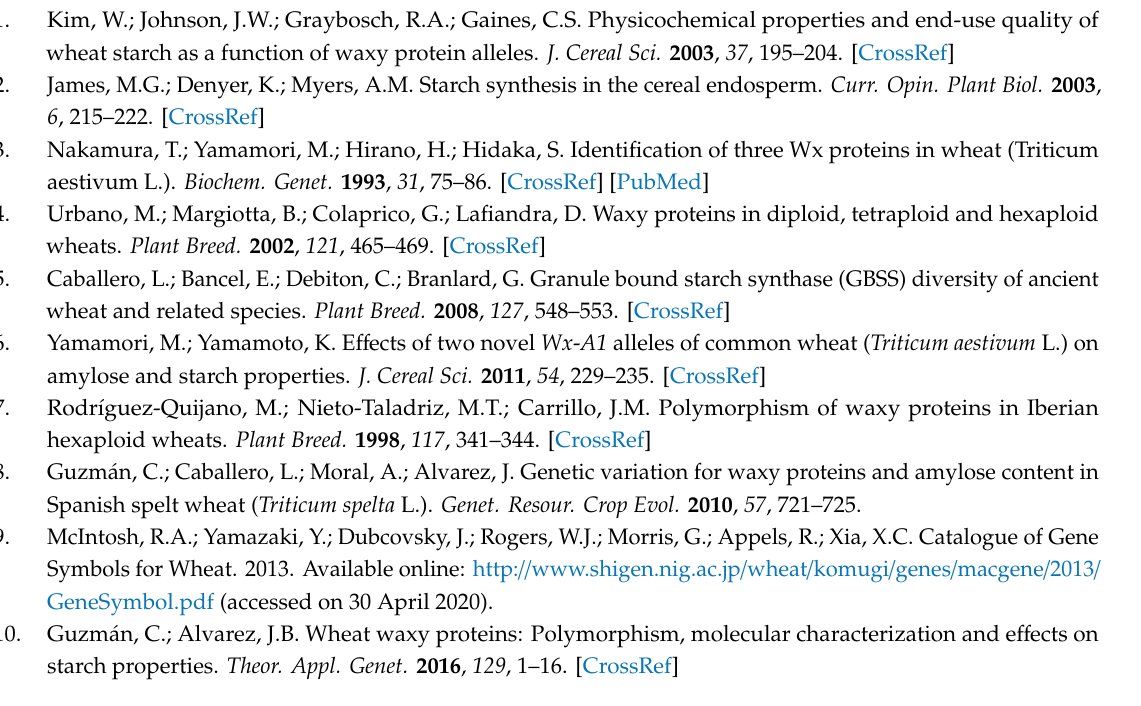
Figure S1: Nucleotide sequences of the Wx genes-ortholog fragment I of (from to bottom) Th.bessarabicum ( Wx-Jb1 -I#1), P.stipifolia ( Wx-Psstip1 -I#1, Wx-Psstip1 -I#2), Th.intermedium ( Wx-Thint1 -I#1, Wx-Thint1 -I#2), Th.ponticum ( Wx-Thpon1 -I#1) aligned against mRNA of bread wheat Wx genes, Wx-A1a (EU719608.1, mRNA), Wx-B1a (EU719610.1, mRNA), Wx-D1a (EU719612.1, mRNA). Figure S2: Nucleotide sequences of the Wx genes-ortholog fragment II of (from to bottom) of Th.bessarabicum ( Wx-Jb1 -II#1, Wx-Jb1 -II#2), P.stipifolia ( Wx-Psstip1 -II#1, Wx-Psstip1 -II#2, Wx-Psstip1 -II#3), Th.intermedium ( Wx-Thint1 -II#1, Wx-Thint1 -II#2, Wx-Thint1 -II#3), Th.ponticum ( Wx-Thpon1 -II#1, Wx-Thpon1 -II#2, Wx-Thpon1 -II#3) aligned against mRNA of bread wheat Wx genes, Wx-A1a (EU719608.1, mRNA), Wx-B1a (EU719610.1, mRNA), Wx-D1a (EU719612.1, mRNA). Figure S3: Nucleotide sequences of the Wx genes-ortholog fragment III of (from to bottom) Th.bessarabicum ( Wx-Jb1 -III#1), P.stipifolia ( Wx-Psstip1 -III#1, Wx-Psstip1 -III#2), Th.intermedium ( Wx-Thint1 -III#1), Th.ponticum ( Wx-Thpon1 -III#1, Wx-Thpon1 -III#2, Wx-Thpon1 -III#3, Thpon1 -III#4, Thpon1 -III#5) aligned against mRNA of bread wheat Wx genes, Wx-A1a (EU719608.1, mRNA), Wx-B1a (EU719610.1, mRNA), Wx-D1a (EU719612.1, mRNA). Table S1: The